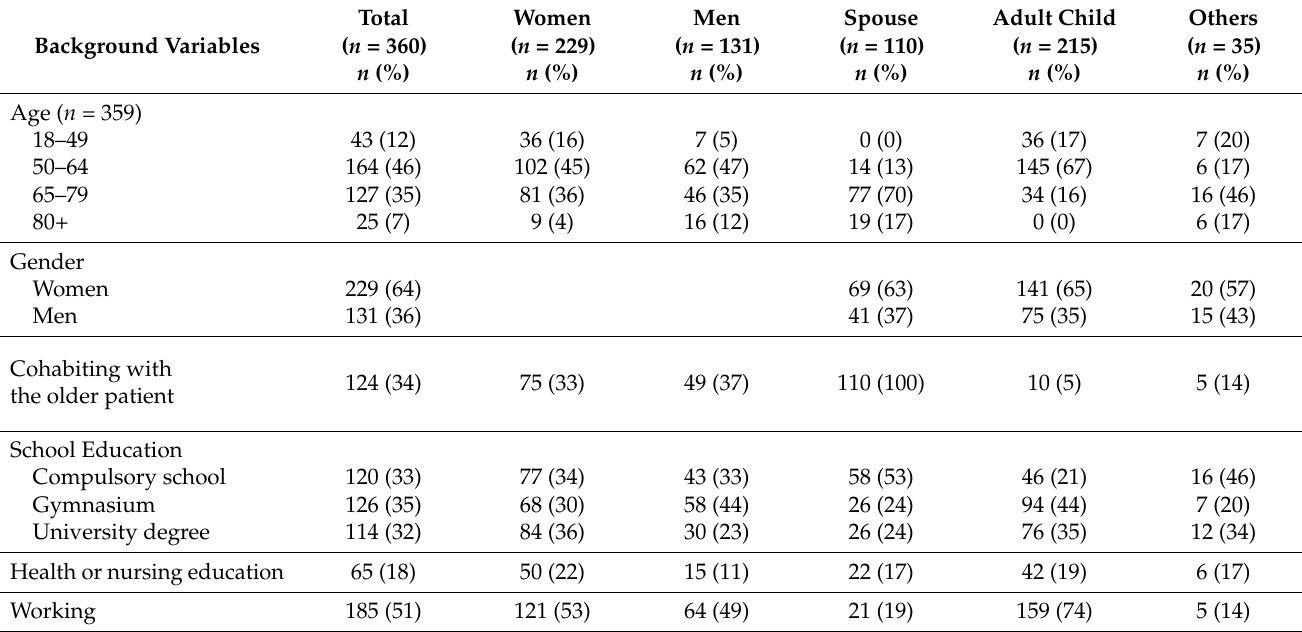
Table 1. Characteristics of